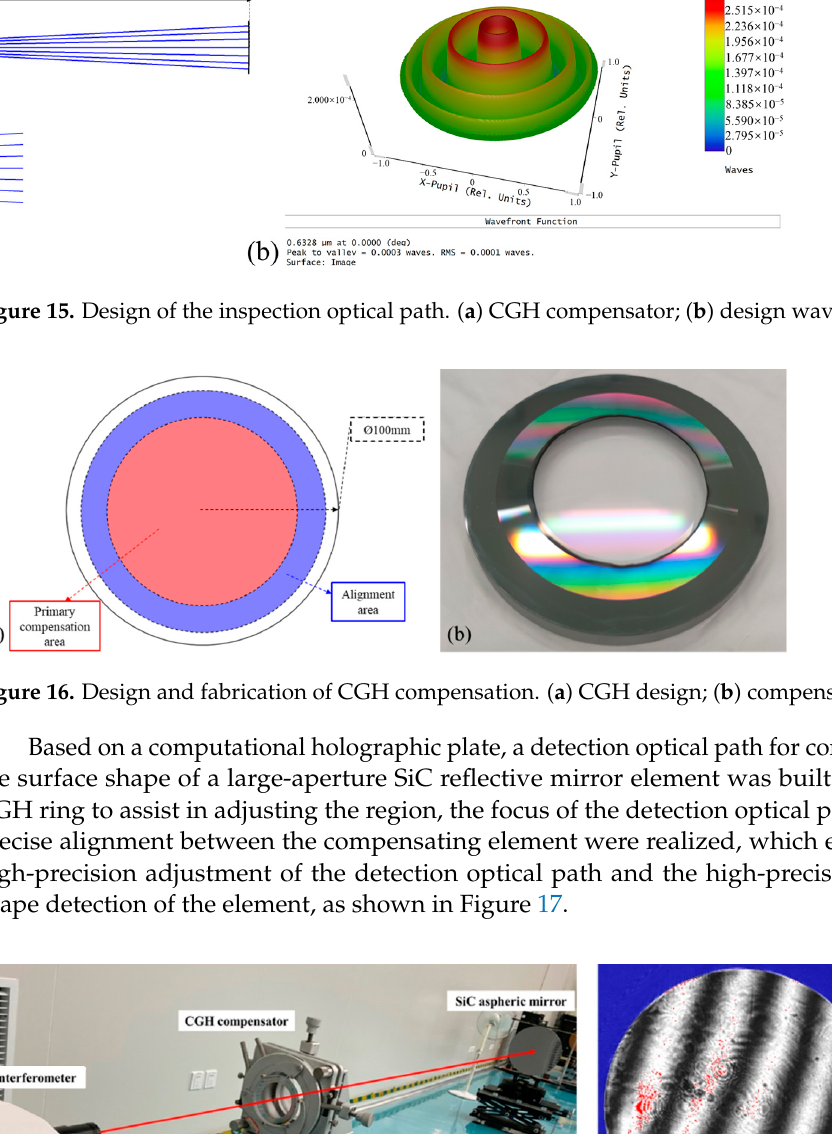
Figure 15. Design of the inspection optical path. ( a ) CGH compensator; ( b ) design wavefront.